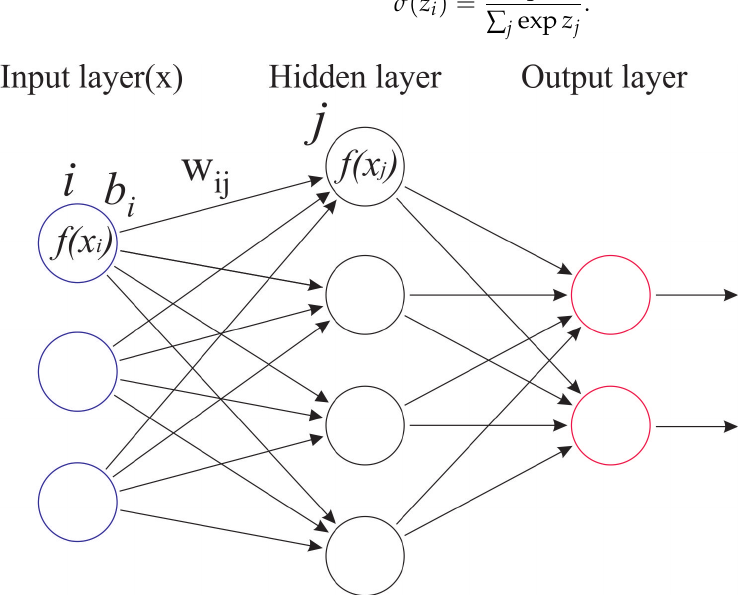
Figure 5. Schematic of artificial neural